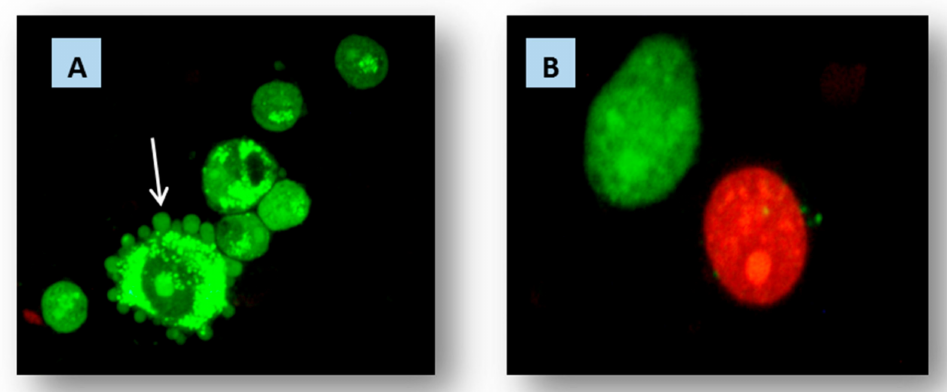
Figure 8. ( A ) HepG2 apoptotic bodies induced by 20HAP@MgO composite; ( B ) Necrosis (red cell) after treatment with 60HAP@MgO. Cells were incubated in a 5% CO 2 incubator for 48 h. and stained